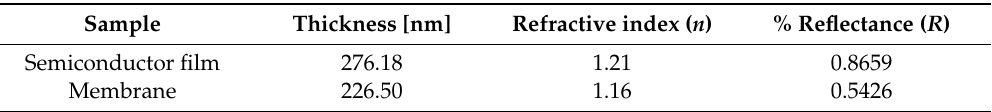
Table 2. Characteristic parameters of membrane and semiconductor